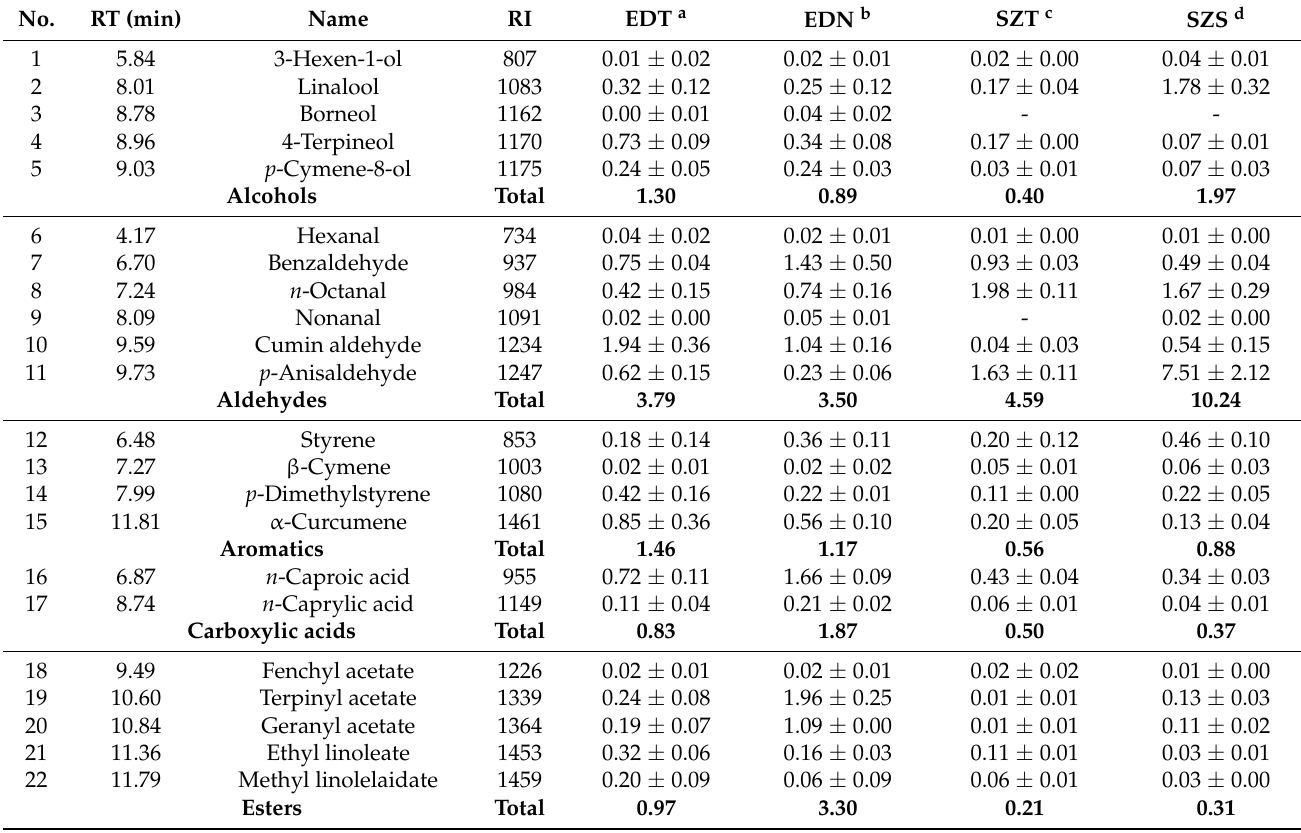
Table 1. Relative percentage of volatile components in Egyptian dukkah and Syrian za’atar